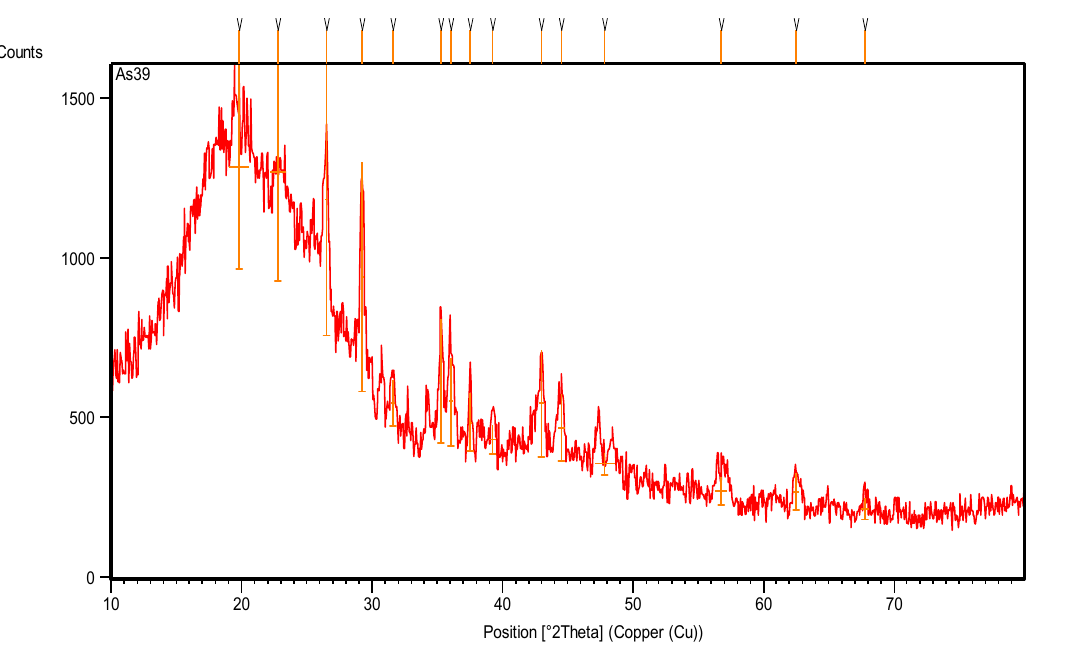
Figure 3. XRD pattern of original rubber scrap tire before treatment. Table 1. XRD intensity scan data of original scrap tire before treatment.